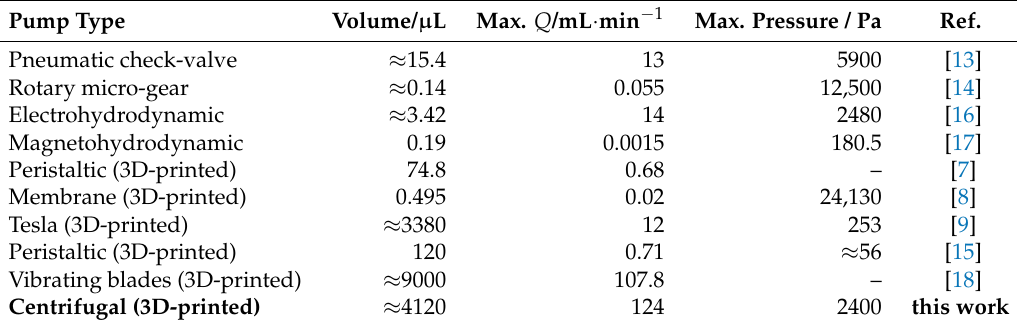
Table 1. Comparison of selected miniaturized and 3D-printed pump types with this work, estimating pump chamber volume and giving maximum flow rate Q and maximum output pressure.